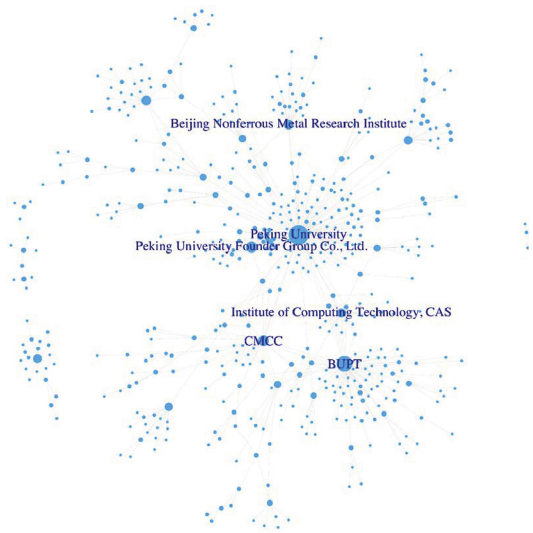
Figure 8: Community of Innovation with multiple centers of Peking University and BUPT.